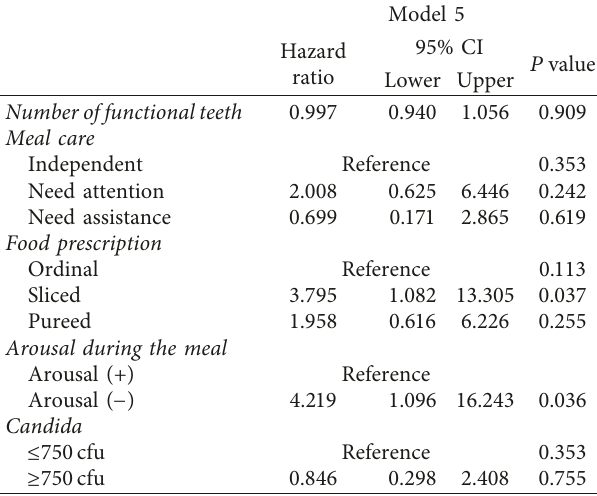
Table 5: Risk factors associated with duration until the incidence of fever after starting the oral care